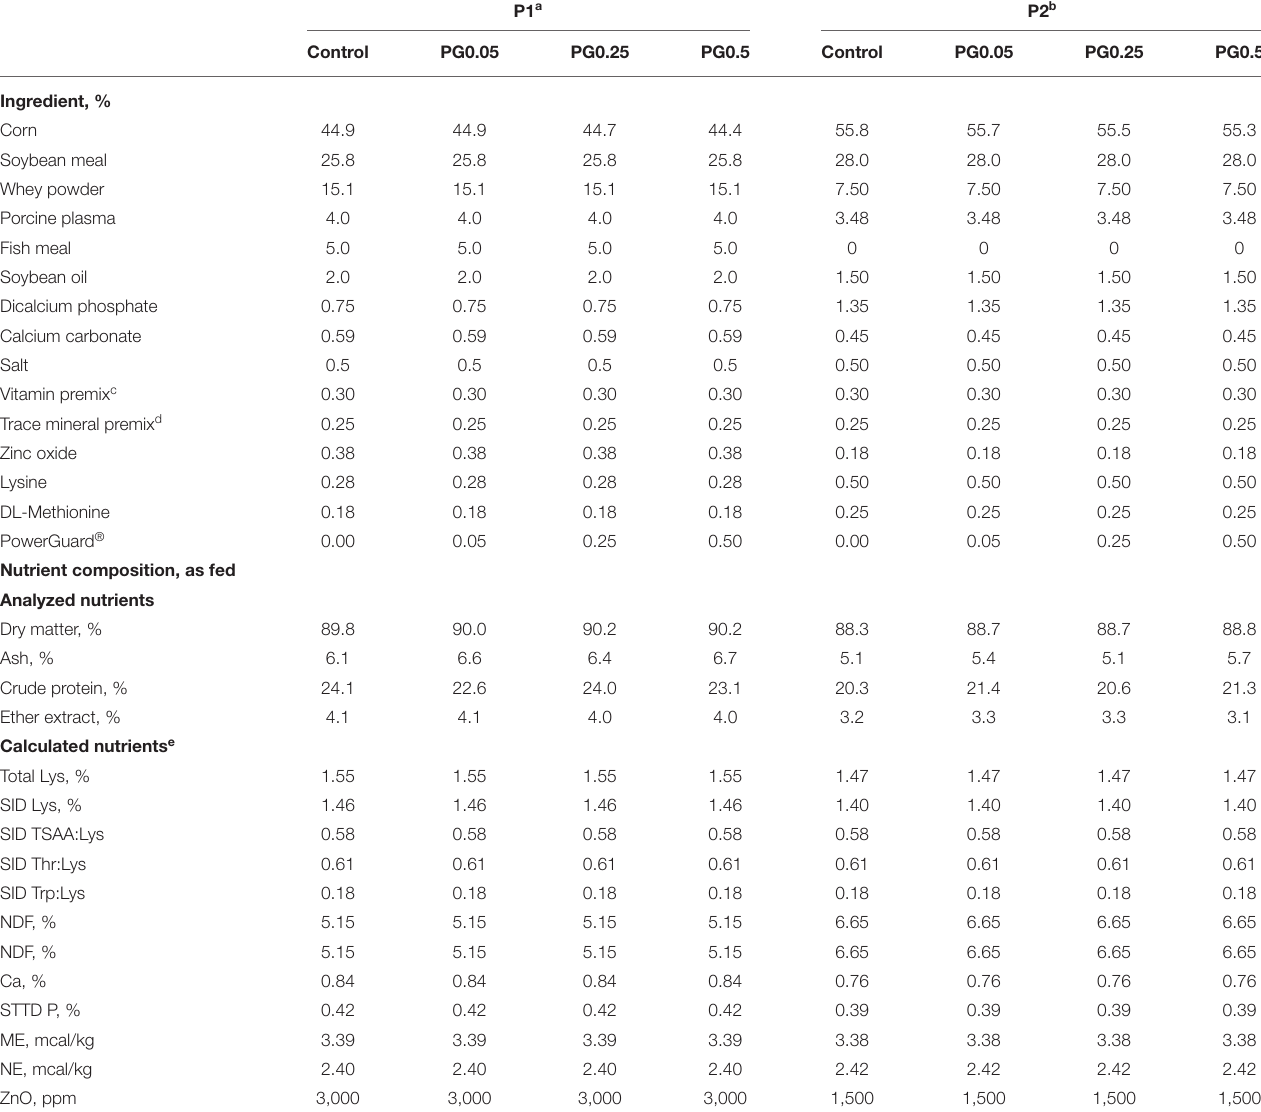
TABLE 1 | The formulated diets fed to weanling pigs from day 21 of life through day